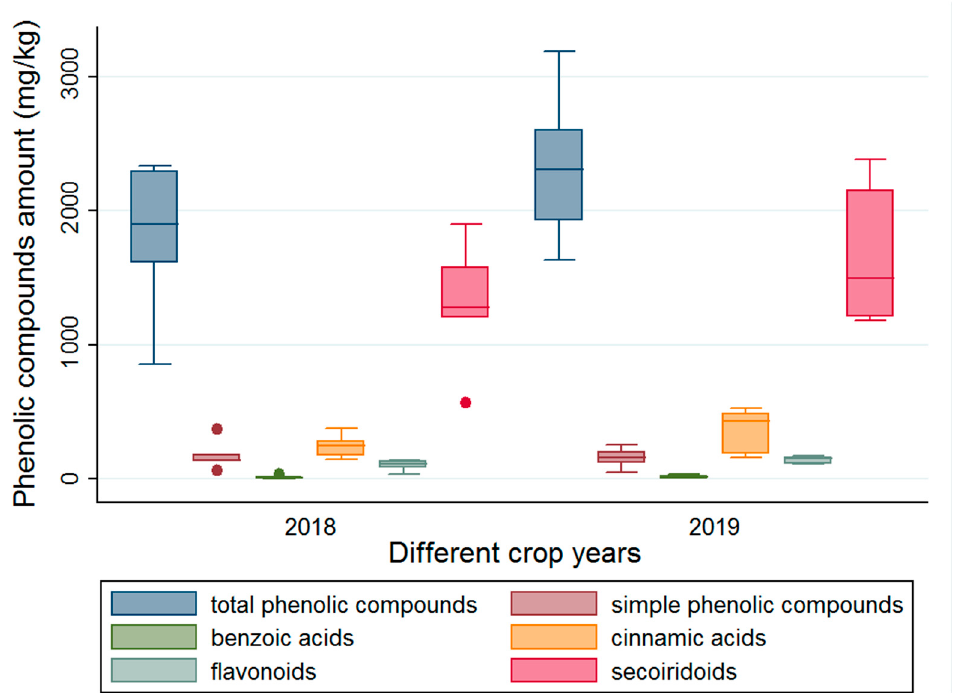
Figure 2. Total phenolic compounds, benzoic acids, flavonoids, simple phenolic compounds, cin- namic acids and secoiridoids determined according to crop years 2018 and 2019.